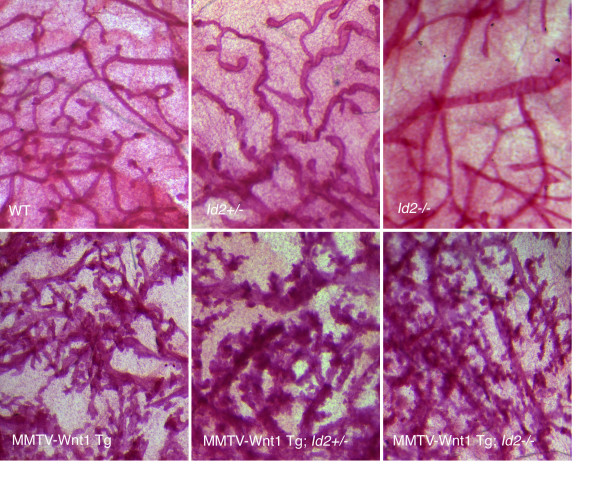
Carmine stained mammary gland whole mounts were made from virgin females. Top row, left to right: normal mammary gland development was observed in wild type (13 weeks), Id2 +/- (26 weeks), and Id2-/- (26 weeks) animals. Bottom row, left to right: Wnt1 induced hyperplasia and side branching were forced when the MMTV-Wnt1 transgene was present in wild type, Id2+/-, and Id2 -/- animals (all 19 weeks). Branching patterns are representative of a consistent phenotype observed in all mice and in both tumor-free glands and in glandular tissue associated with tumors in the MMTV-Wnt1 mice.